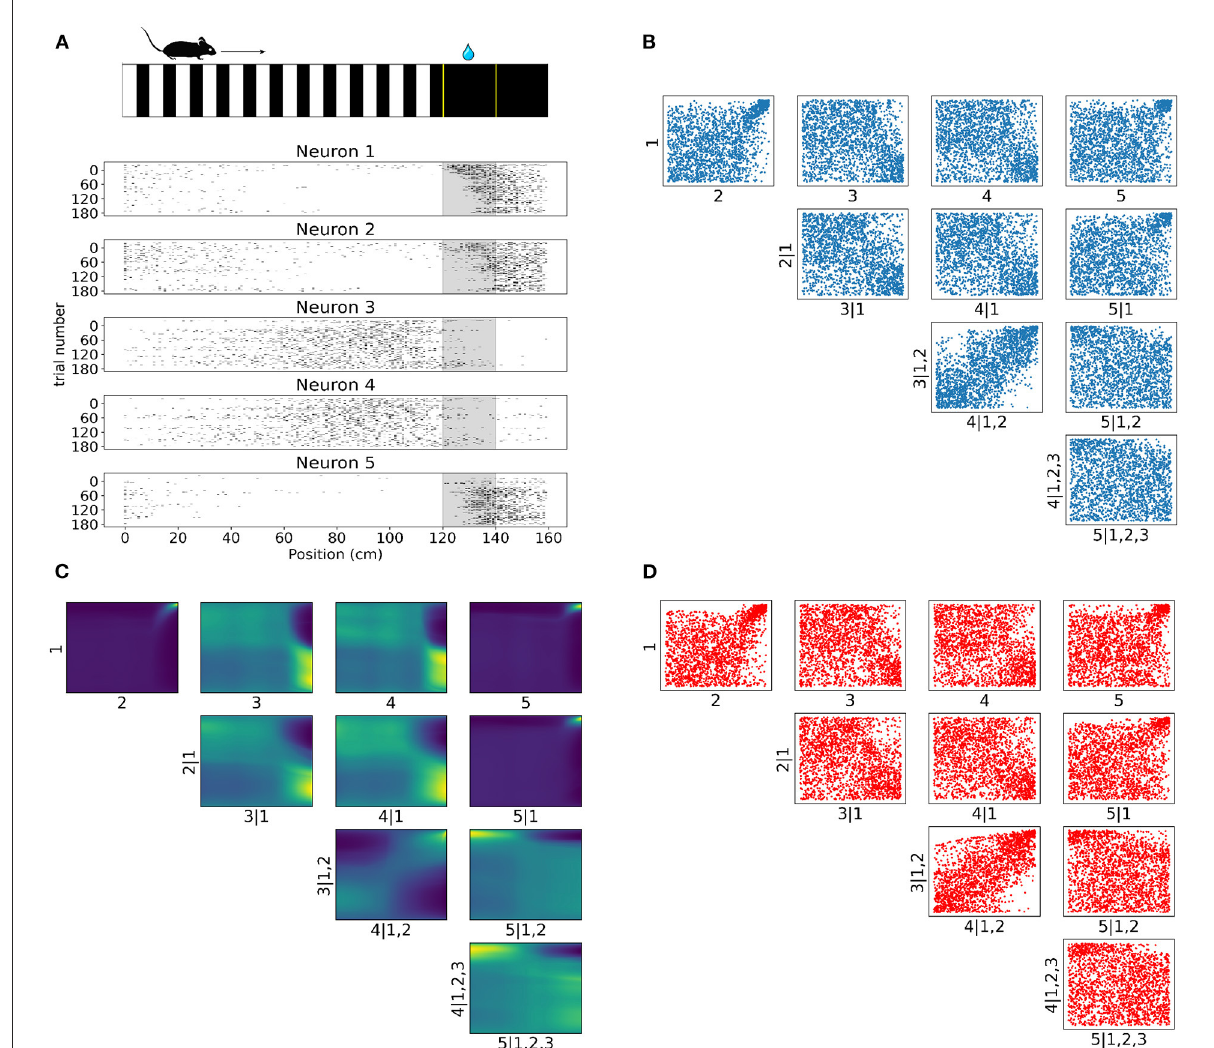
FIGURE6 Tail dependencies in position dependent V1 activity are captured by NSF vine copulas. (A) Illustration of mouse navigating a virtual environment with grating stimuli until it reaches the reward zone (120–140 cm) where it is required to lick in order to receive water reward. Raster plots for five neurons in V1 rodent data across trials and position (a smaller bin size of 2.5 cm is used here for illustration purposes) in the virtual corridor. Gray region denotes the reward zone. (B) Scatter plots of empirical copula samples (blue dots) in a 5D vine extracted from the spike data. Axis labels denote which unconditional or conditional neuron margins have been transformed to copula space. Margin indices after vertical slash denote those in the conditioning set. (C) Copula densities of the 5-D vine from the trained NSF. (D) Simulated samples (red dots) from the trained NSF copula densities of the 5-D